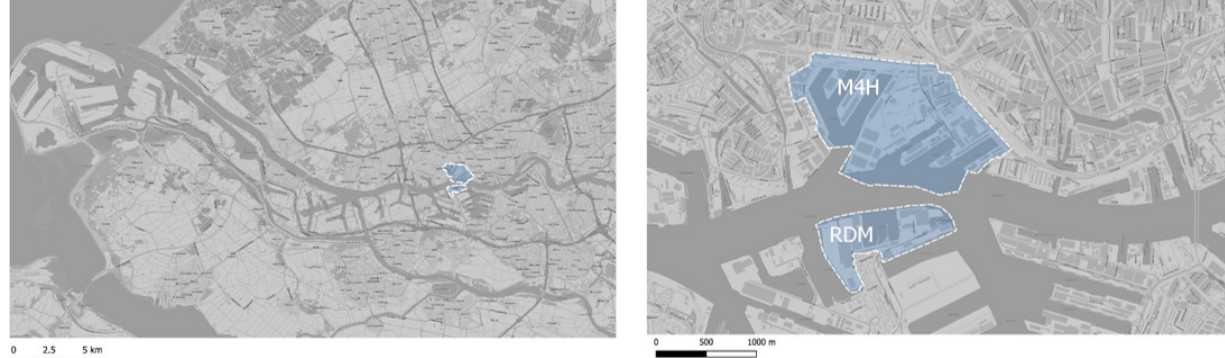
Figure 1. Rotterdam Makers District, located to the West of the city centre. The port industrial activities have expanded westwards. Source: Figure by Erasmus UPT (2020), based on Publieke Dienstverlening op de Kaart (2021). Urban Planning, 2021, Volume 6, Issue 3, Pages